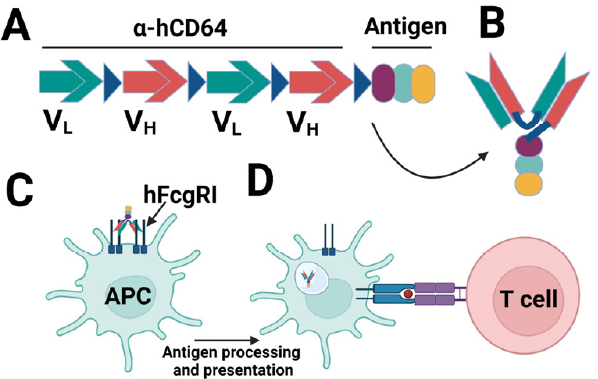
Figure 3. α -hCD64-targeted vaccine design: ( A ) The map of the candidate vaccines. ( B ) Folding of the α -hCD64 and antigen moieties. ( C ) The α -hCD64-Antigen binds to the hFc γ RI on APCs. ( D ) APCs in turn process and present the antigens to the naïve T cells.